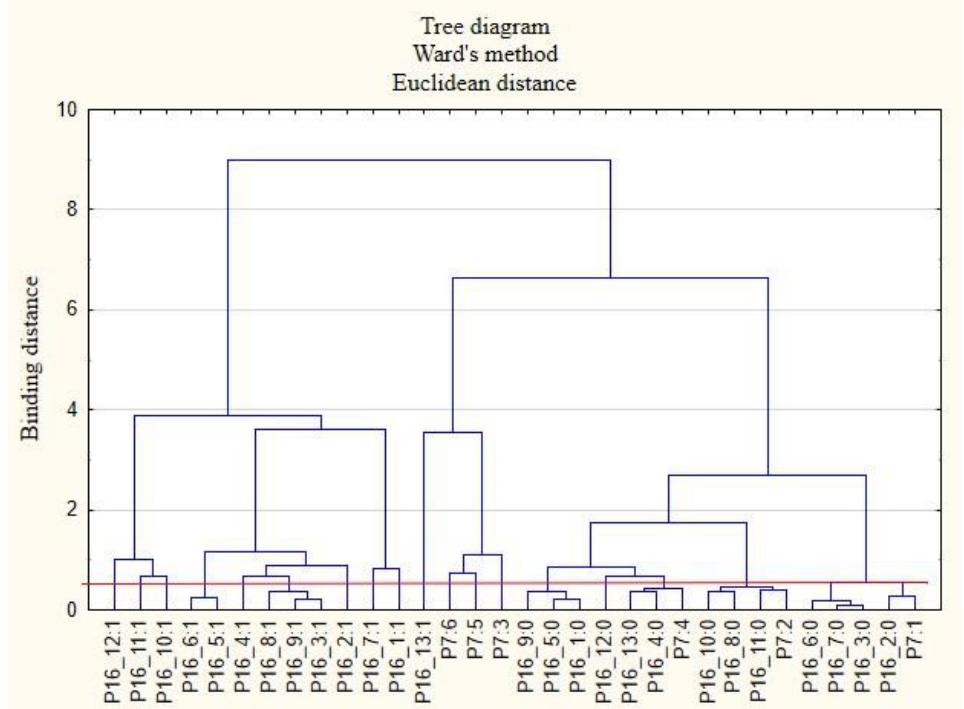
Figure 12. Diagram of hierarchical classification of variable categories: support that respondents want to receive after the end of the COVID-19 pandemic from the employer in the area of health care and the effective use of the benefits offered (P16) as well as the forms of employment of the respondents (P7).